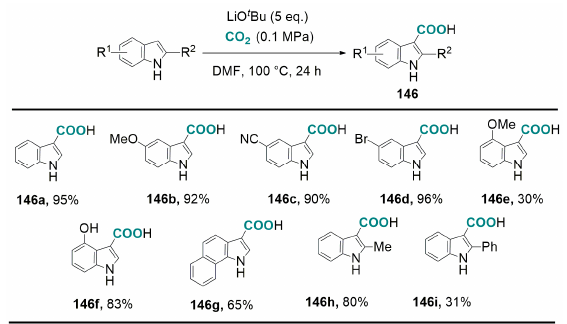
Scheme 60. Selected examples for carboxylation reactions of indole derivatives with CO 2 .